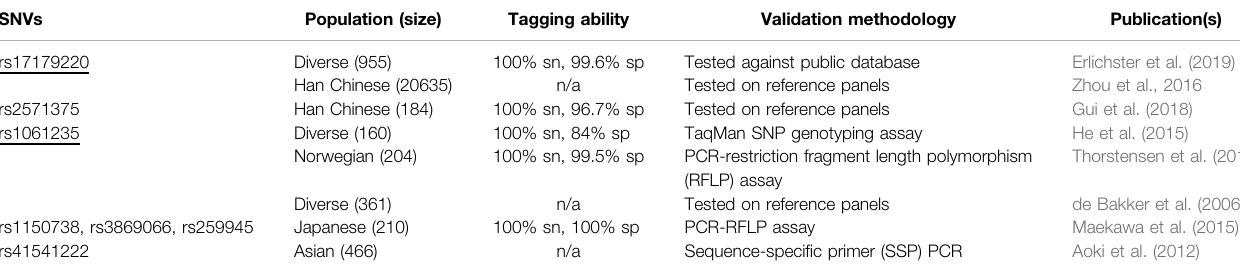
TABLE 1 | Prior data on HLA-A*31:01 potential tag SNVs. SNVs